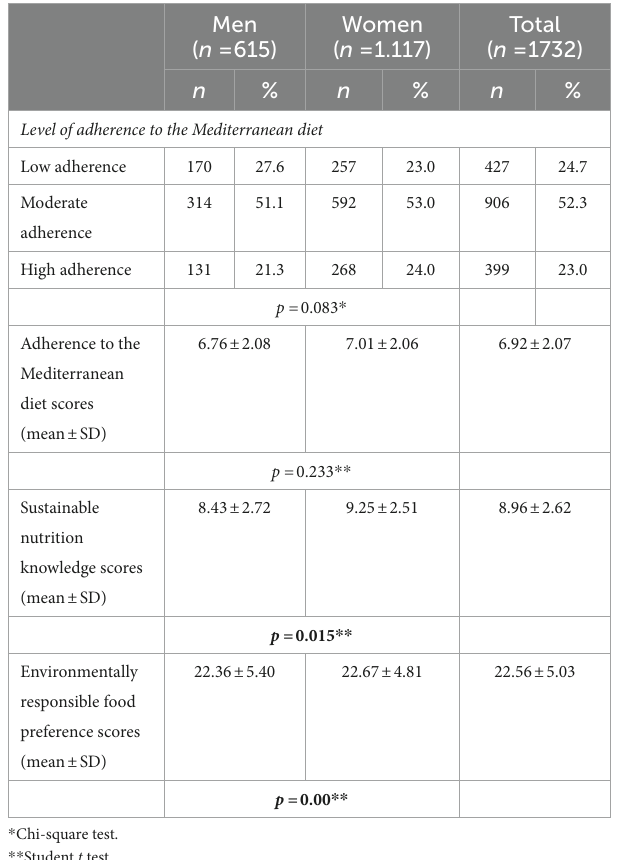
TABLE 2 Adherence to the Mediterranean diet, sustainable nutrition knowledge and environmentally responsible food preference scores of the